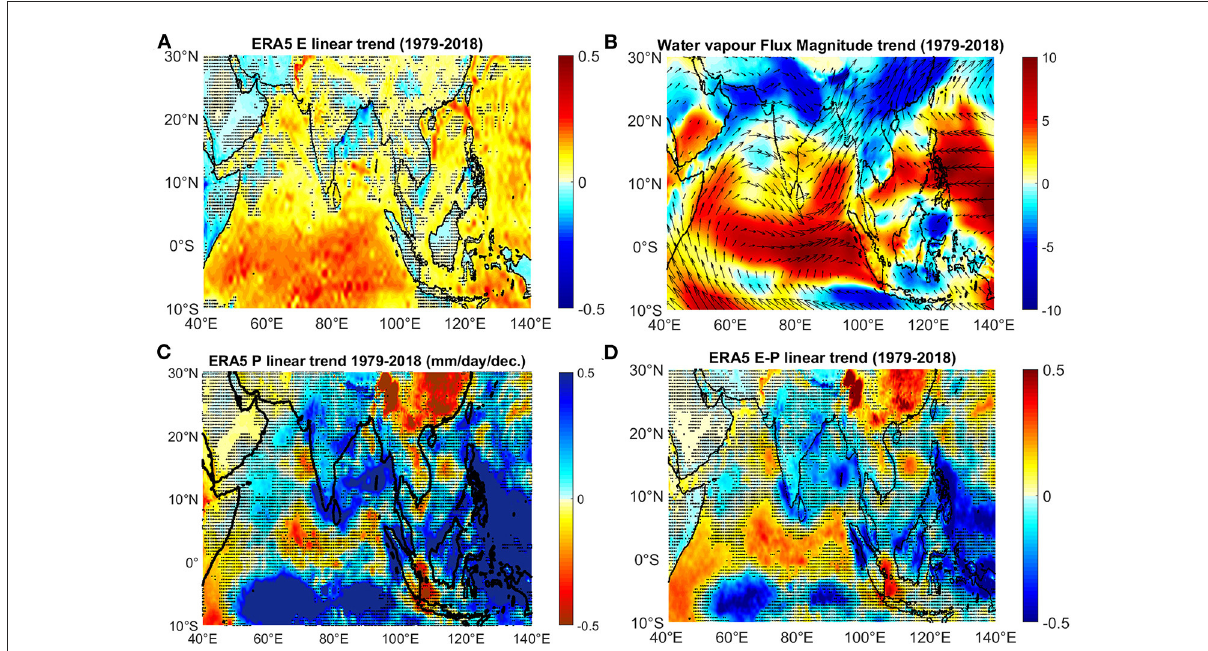
FIGURE8 ERA5 annual linear trends (1979–2018) in (A) Evaporation (mm/day/dec.); (B) Magnitude of vertically integrated atmospheric water vapor transport (kg m − 1 s − 1 /dec.) (C) Precipitation (mm/day/dec.); (D) Evaporation minus Precipitation (mm/day/dec.); The climatological